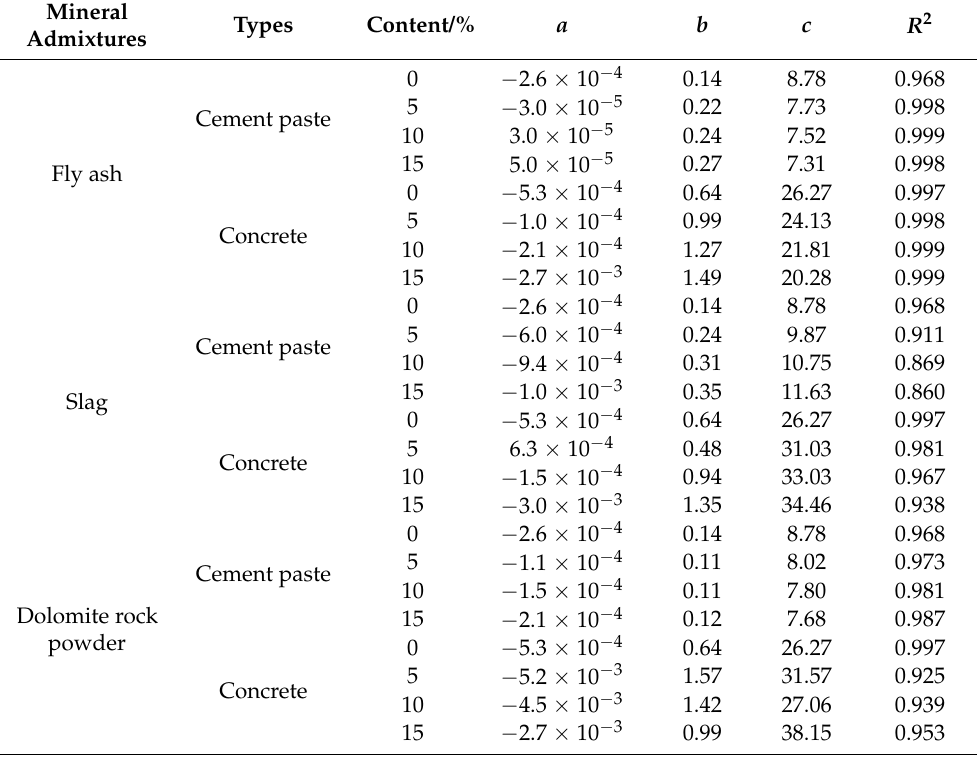
Table 4. The fitting results between the electrical resistivity and mass ratios of mineral